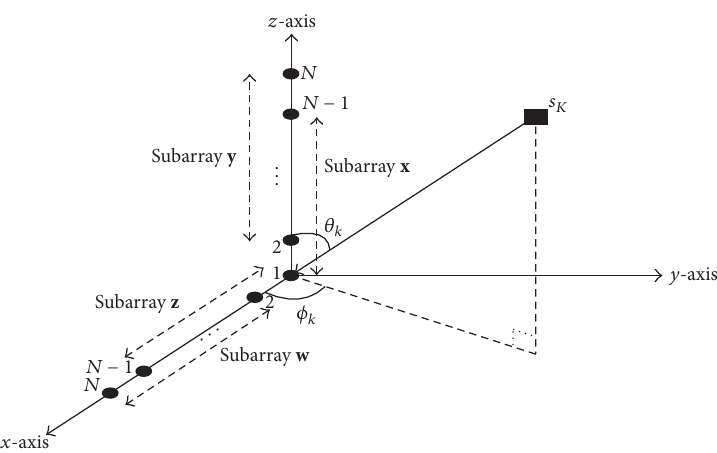
Figure 1: Configuration of array geometry for 2D DOA azimuth and elevation